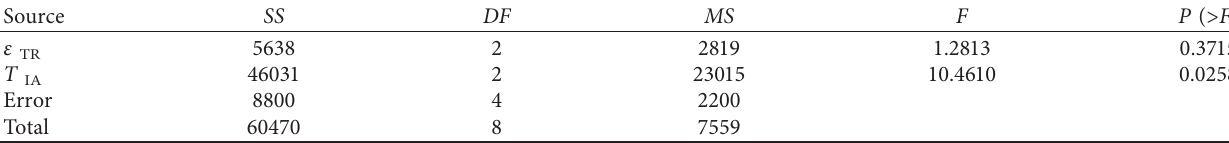
Table 4: ANOVA for ultimate tensile strength.